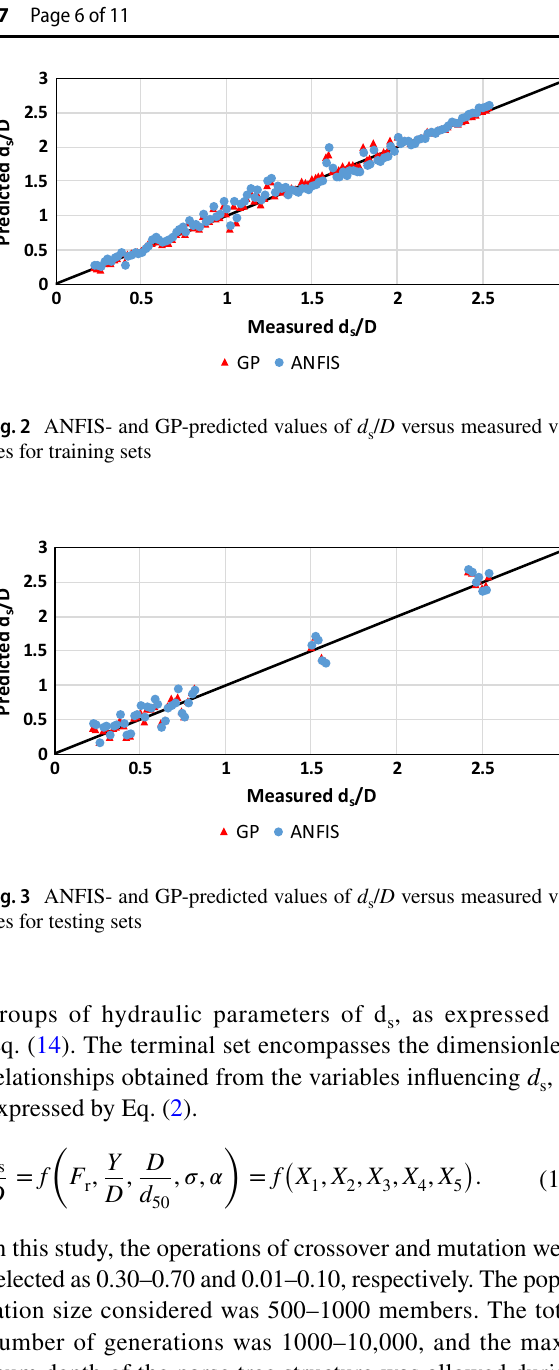
Fig. 4 ANFIS- and GP-predicted values of d